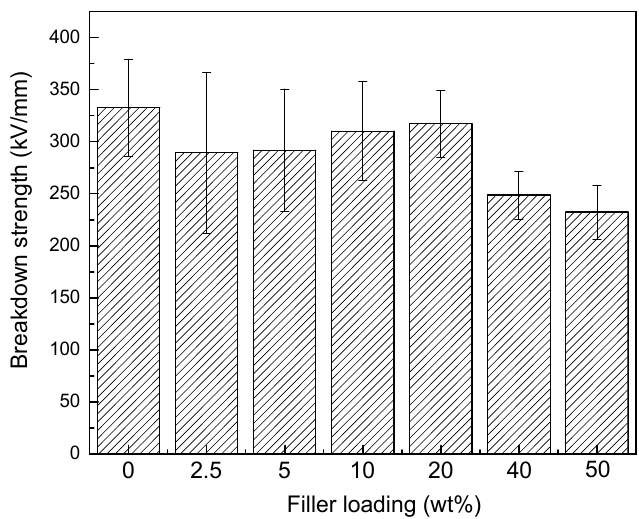
Figure 7. Breakdown strength histogram (mean and standard deviations) of RIP with different h-BN nano-flakes components.